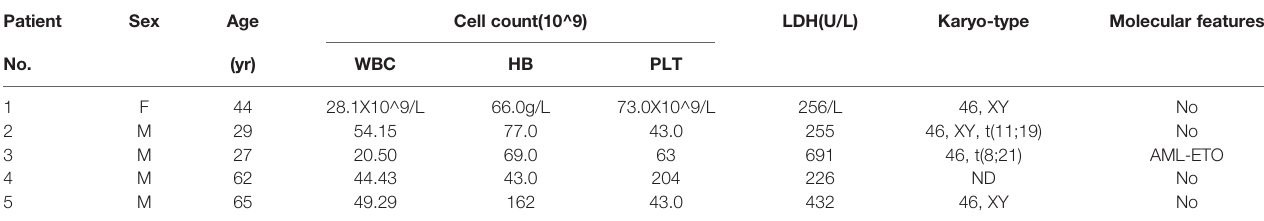
TABLE 3 | The characteristics of 5 cases diagnosed with de novo or refractory/relapsed acute myeloid leukemia.